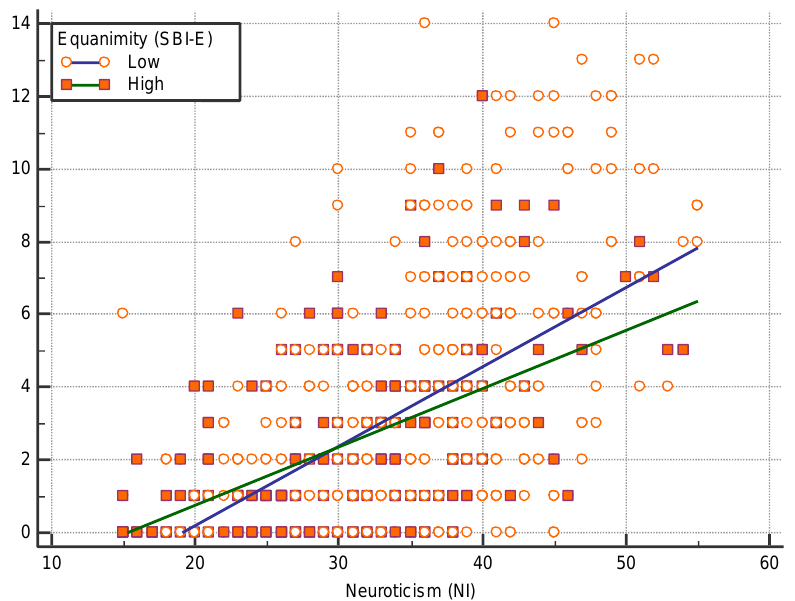
Figure 3. Regression lines between CSI-D and NI scores based on level of equanimity.